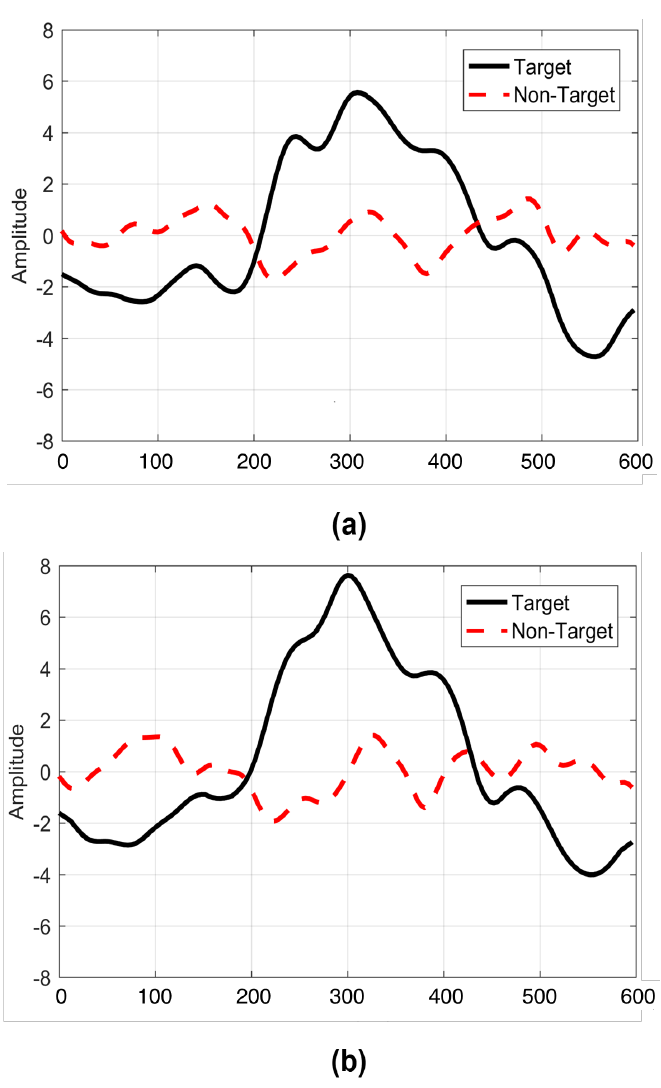
Figure 7. Waveforms for target and non − target stimuli. ( a ) Primary symbols − based display for controlling home appliances. ( b ) Secondary display (Numbers − based) for making phone calls.